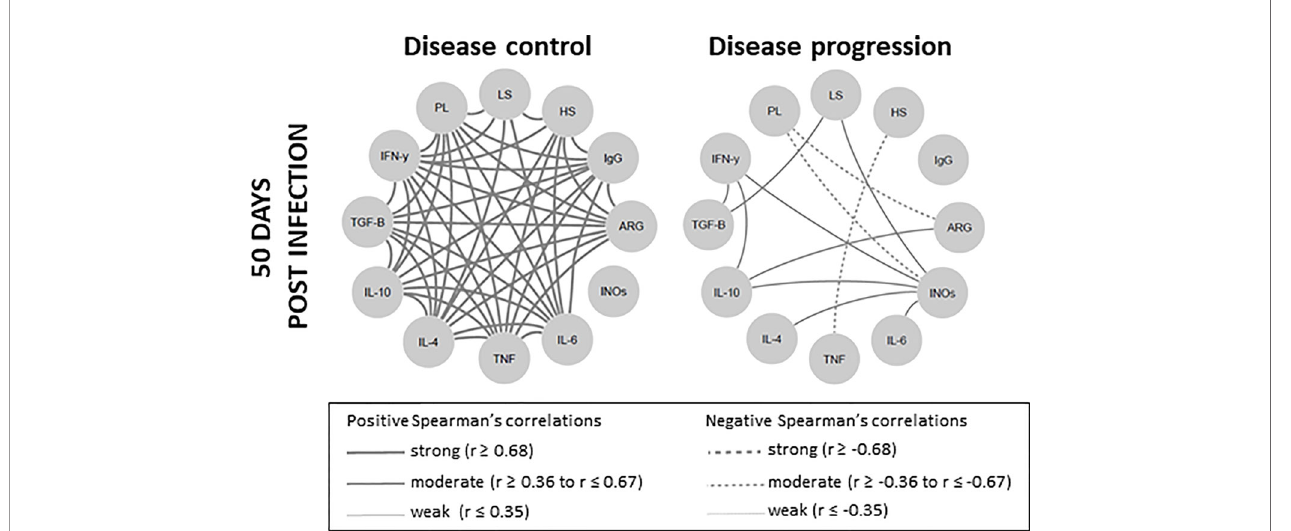
FIGURE 7 | Skin lesion clinical outcome is correlated with degree of network interaction involving clinical, parasitological and immunological biomarkers in Leishmania Viannia braziliensis -infected hamsters. Network interactions evaluated between animals were subdivided into two clinical fates, according to lesion size and parasite load, as disease control (lesions smaller than 1mm and parasitic load <10 2 ) and disease progression (lesions larger than 1mm and parasitic load > 10 2 ). Signi fi cant Spearman correlations were considered when p ≤ 0.05 and were represented by lines connecting the circle nodes. The strength of the correlation index was represented by the connecting line thickness. PL, parasite load; LS, lesion size; HS, histopathology score; ARG, arginase; INOs, oxide nitric sintase; Cytokine genes – TNF, TGF- b , IFN- g , IL-10, IL-6,